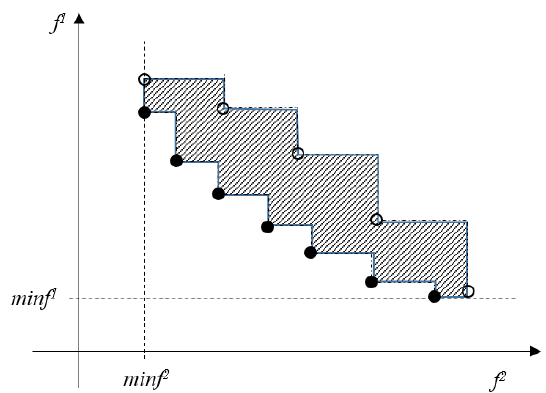
Figure 1. The solutions of the Pareto front are depicted by the black circles, and elements of the NDSS correspond to the empty circles. The difference in the areas is depicted by hatched area.